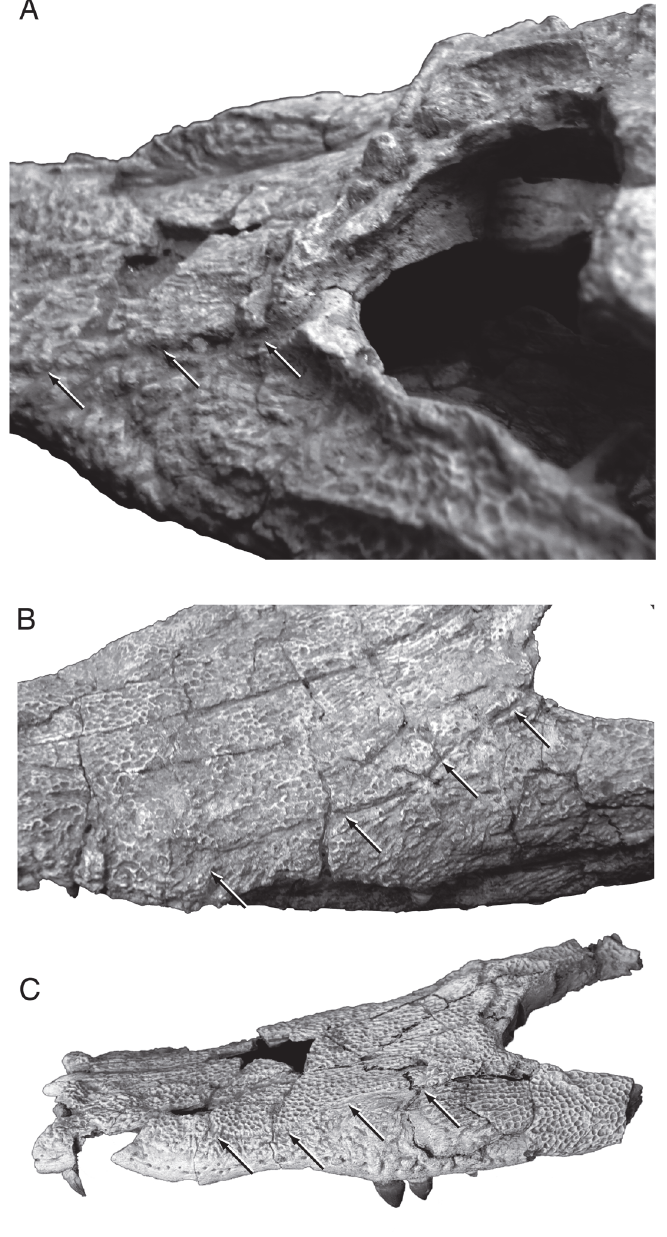
Fig 11. Orbitonasal sulcus variation in Paralligatoridae. A , Shamosuchus ulanicus (= Paralligator gradilifrons ) (PIN 3140-502), left side; B , S . (= Paralligator ) gradilifrons (PIN 554-1, holotype), left side; C , S . tersus (= Paralligator gradilifrons ) (PIN 3141-501), left